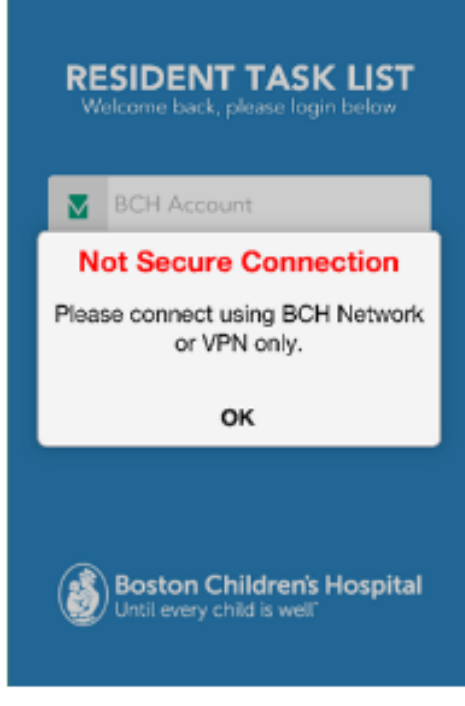
Figure 2. Tasklist runs on secured network